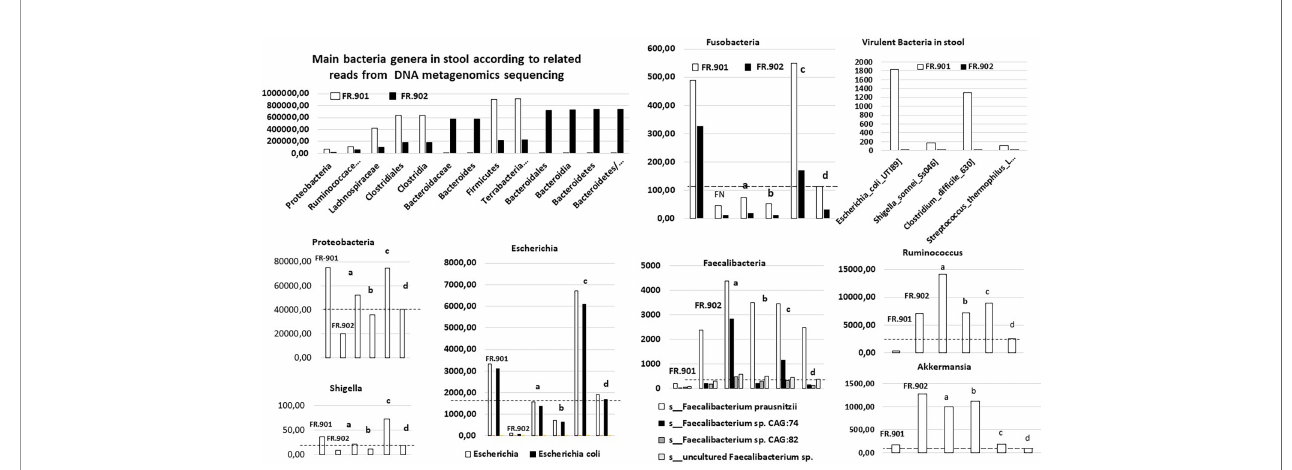
FIGURE 1 | Levels of bacteria sequences, as assigned by whole metagenome sequencing [for methods see (Zeller et al., 2014; Sobhani et al., 2019)], by using the diamond software (MEGAN6) program and referring to the complete NCBI non-redundant protein database in two monozygotic twin sisters. The raw data are compared with values from our prospective cohorts, including patients with invasive CRC and those with precancerous polyps in the colon. The mean (a) and median values (b) in the adenomatous cohorts ( n = 47), and the mean (c) and median values (d) in the CRC patient cohort ( n = 187) are indicated for each bacteria; discontinued horizontal bars fi t with the median value in the CRC patient cohort; FR-901 and FR-902 are the design code numbers of the CRC patient and her monozygotic sister,